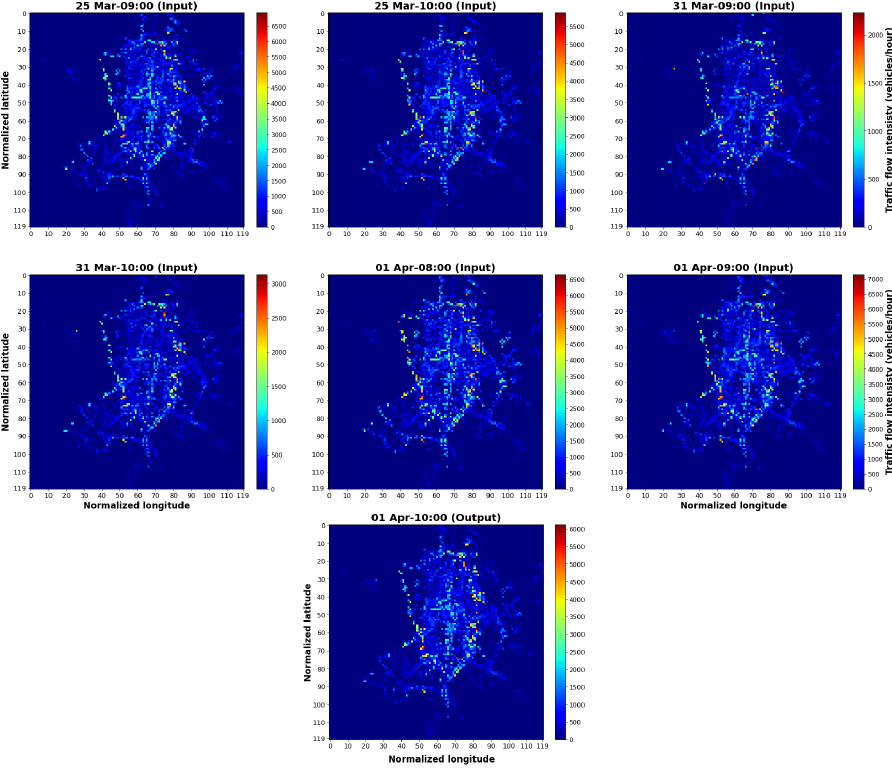
Figure 5. One possible input and expected output for the